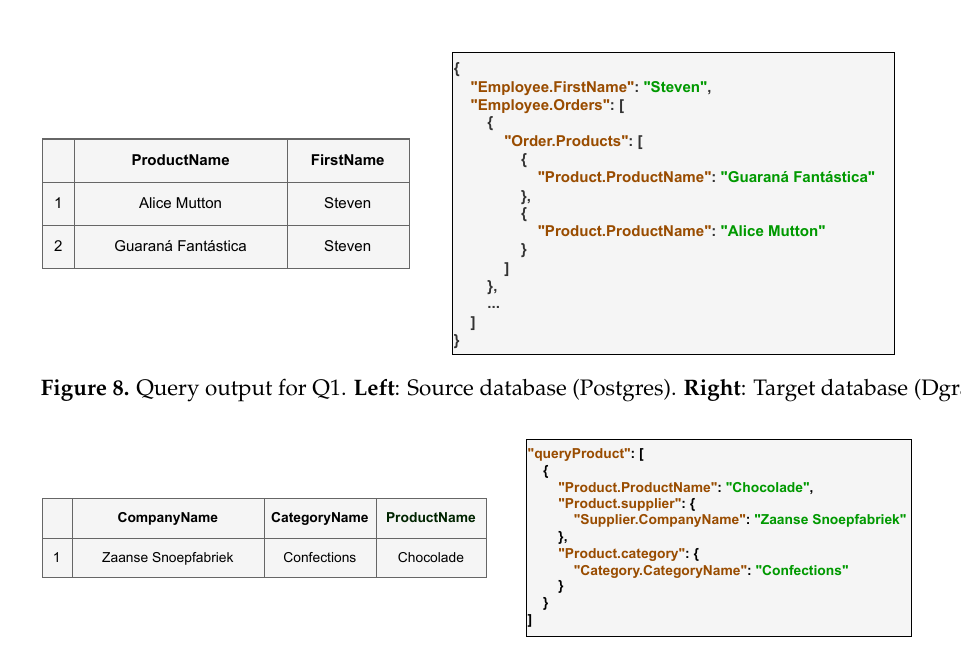
Figure 9. Query output for Q2. Left : Source database (Postgres). Right : Target database (Dgraph).